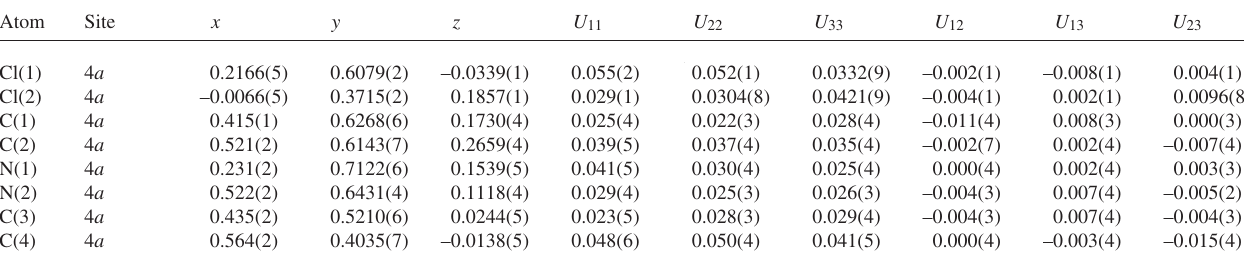
Table 3. Atomic coordinates and displacement parameters (in Å 2 ) .